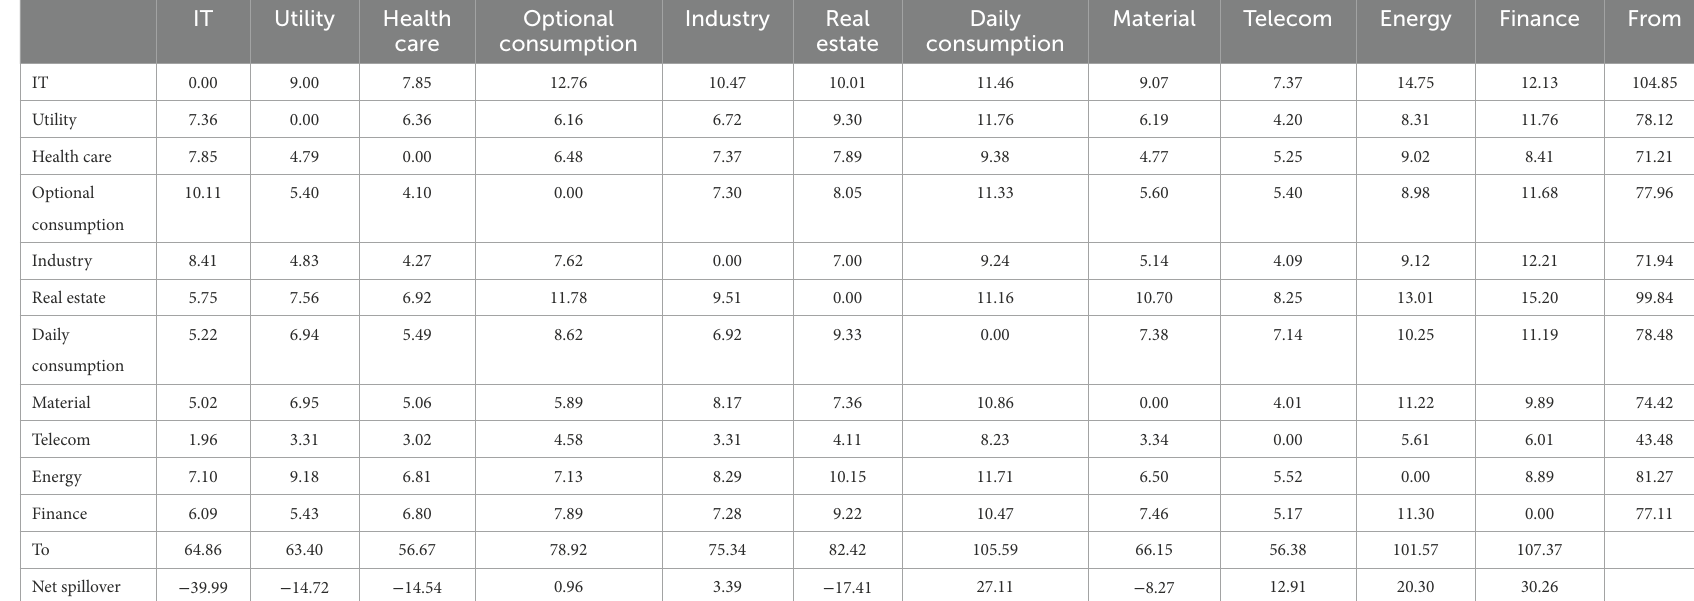
TABLE 5 Intersector total systemic risk contagion network.